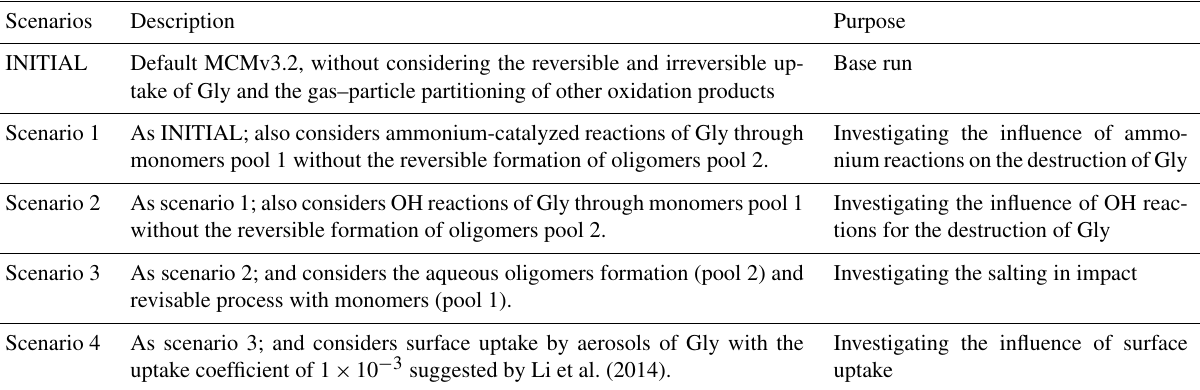
Table 1. Model scenarios used for gas-phase